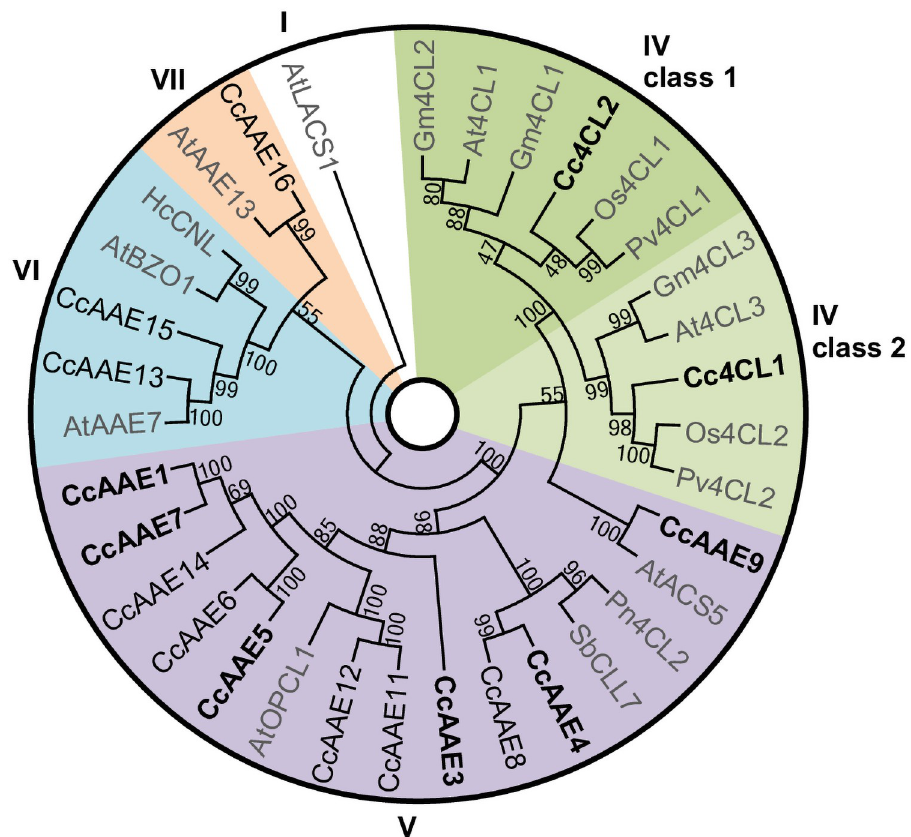
Fig 2. Phylogeny of montbretia acyl activating enzymes (AAEs). Predicted amino acid sequences of montbretia AAEs that showed expression patterns that matched those of known MbA biosynthetic genes during young corm development were aligned with selected AAEs from other plant species. A neighbour-joining tree was built and tested with 1000 bootstrap replicates. Bootstrap values are displayed at branch nodes. Enzyme clades I, IV, V, VI, VII are labelled [11]. Montbretia enzymes characterized in this work are in bold. Only AAE clades reported to contain enzymes that activate aromatic acids were considered. AtLACS1 was used as the outgroup. Cc: Crocosmia x crocosmiiflora , Gm: Glycine max , At: Arabidopsis thaliana , Pn: Piper nigrum , Os: Oryza sativa , Pv: Panicum virgatum , Sb: Scutellaria baicalensis